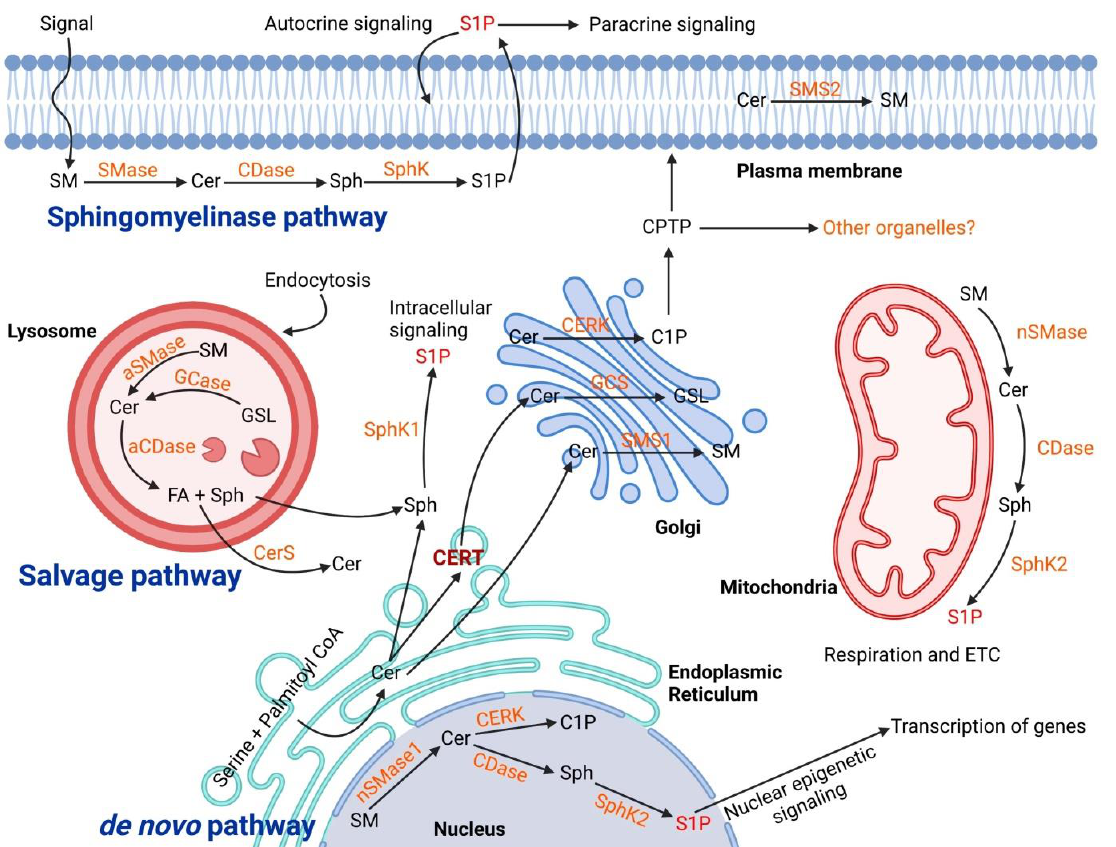
Figure 1. Biogenesis of ceramide in cellular organelles and the complex biochemical pathways in downstream. The ceramide main synthesis routes are De novo in the Endoplasmic Reticulum, Salvage pathway in Lysosome, and Sphingomyelinase both in lysosome and plasma membrane. The transfer of ceramides to the Golgi is mediated through ceramide transfer protein (CERT) within vesicles. In the Golgi, different classes of sphingolipid are synthesized and transported to the cellular sites of action. In the plasma membrane and lysosomes, the main catabolic pathways of sphingolipids are “sphin- gomyelinase (SMase)” to produce ceramides. The produced ceramides go under further metabolism to generate other sphingolipid species such as sphingosine (Sph), sphingosine-1 phosphate (S1P) and also sphingomyelin (SM). Abbreviation: Acid Ceramidase (aCDase), Ceramidase (CDase), Ceramide Kinase (CERK), Ceramide Synthase (CerS), Glucocerebrosidase (GCase), Glucosylceramide Synthase (GCS), Glycosphingolipid (GSL), Sphingomyelin Synthase